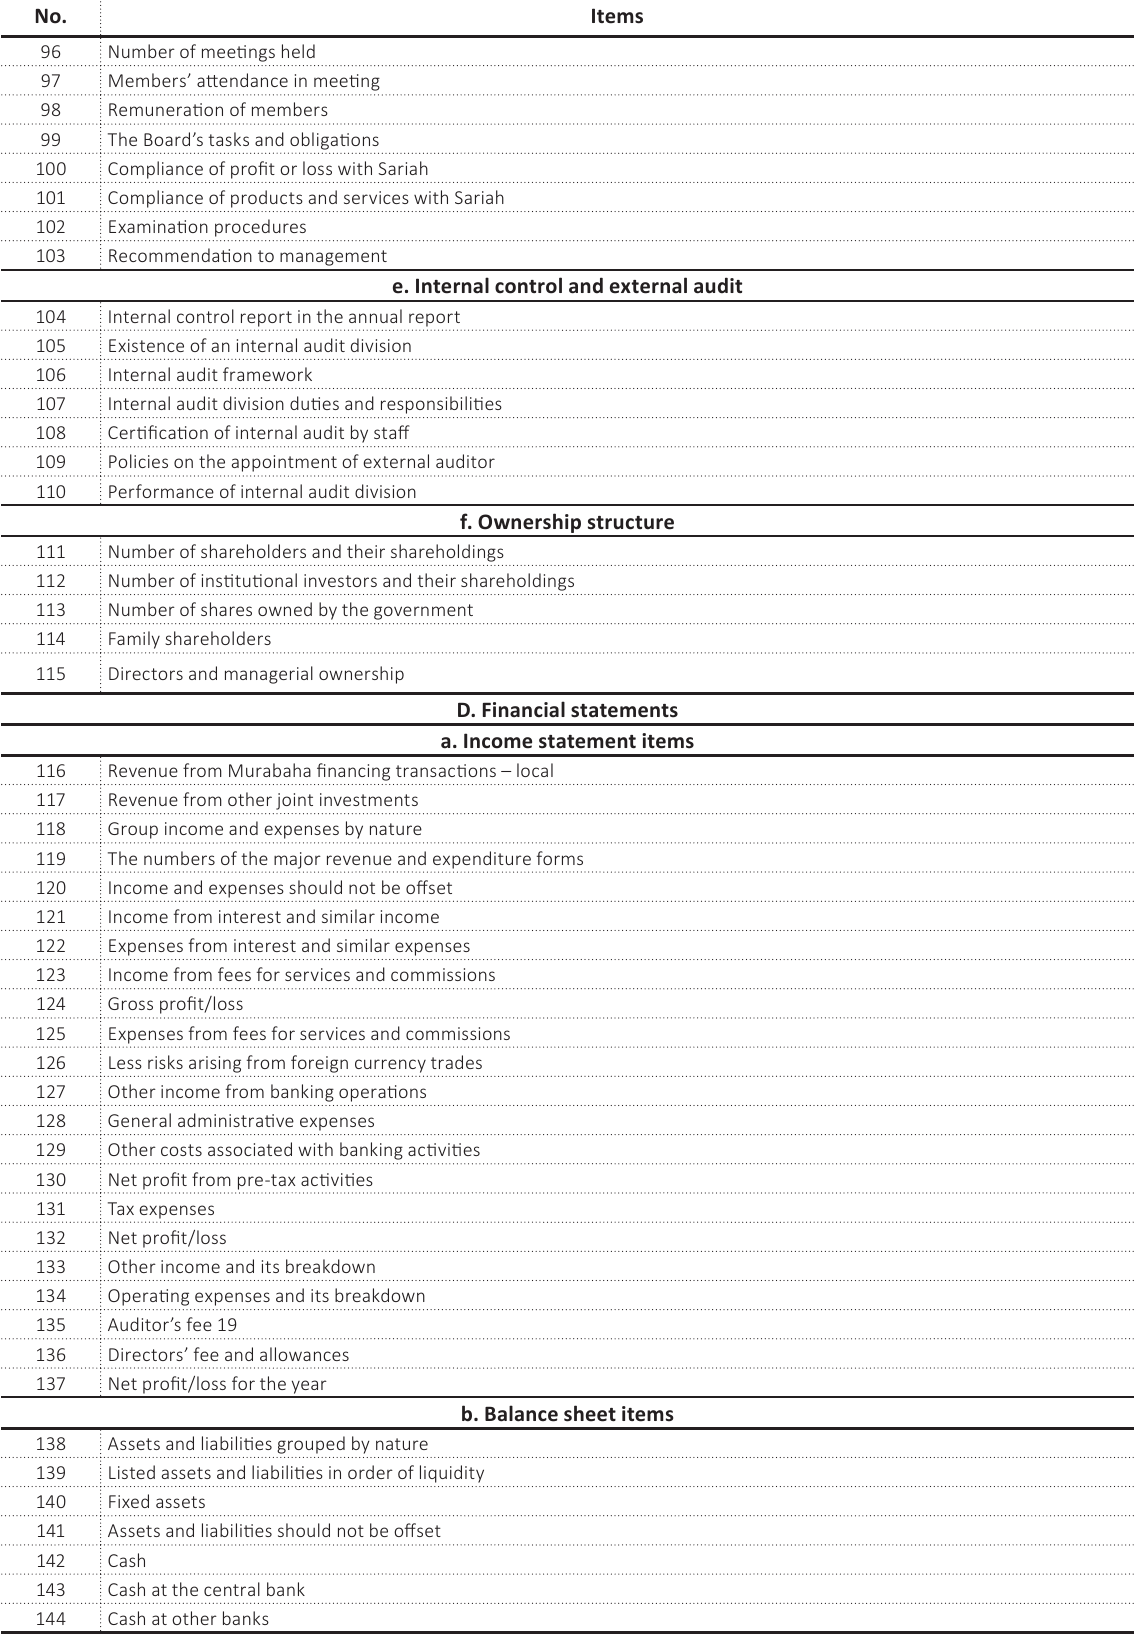
Table A1. (cont.) Voluntary disclosure index